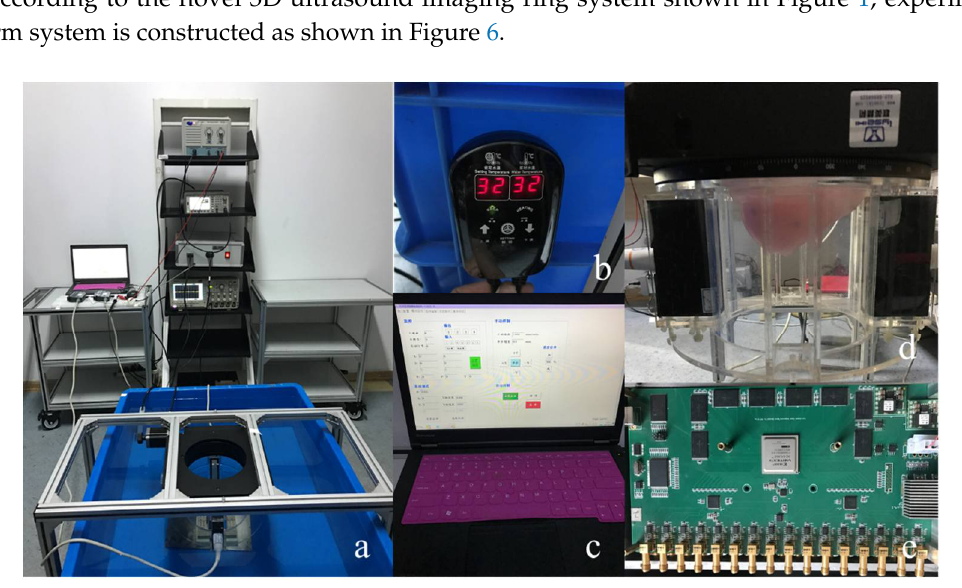
Figure 6. ( a ) Experimental platform system. Placement of breast in the ring; ( b ) Constant temperature heater; ( c ) Personal computer workstation; ( d ) Mechanical alignment device. Transducer ring configuration; ( e ) Ultrasonic signal transmitting and receiving circuits.